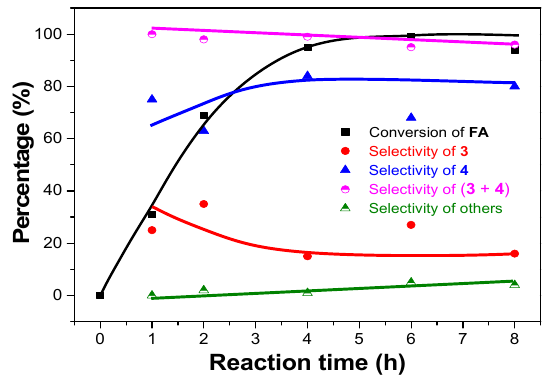
Figure 2. Reaction profiles for the Prins condensation-hydrolysis of isobutene with FA in water over pristine CeO 2 . Reaction conditions: 50 mg CeO 2 , 1.5 mL H 2 O, 0.21 mL HCHO (38 wt %), 3.0 g isobutene, 150 °C.